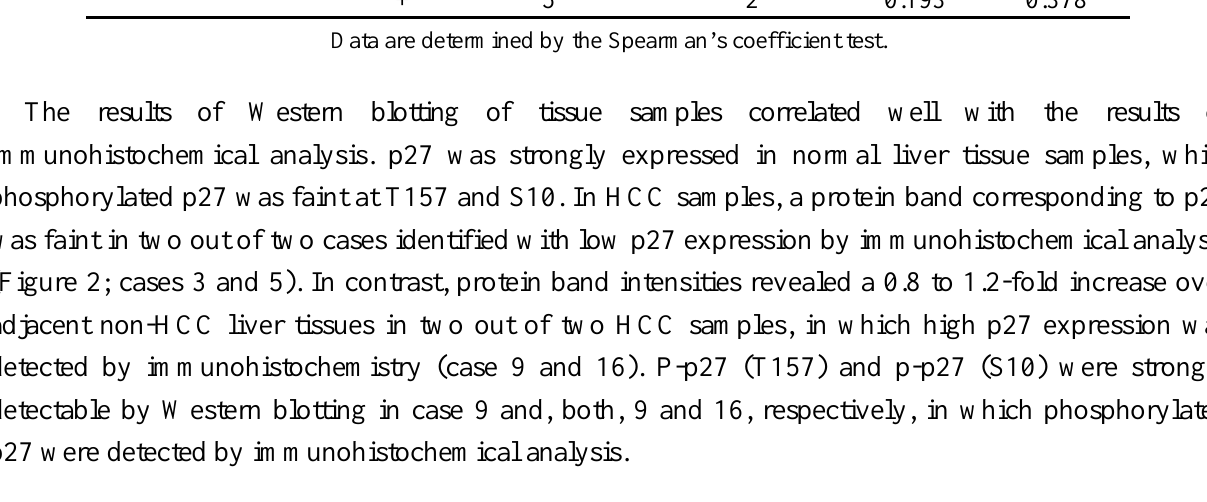
Figure 2. Analysis of p27 expression in HCC in representative tissue samples by western blotting. Numbers represent tissue samples obtained from NASH patients with HCC. The results of immunohistochemical staining (IHC scoring) in each sample are shown at the bottom of each lane. T, tumor tissues; N, adjacent non-tumorous tissue for each HCC sample; normal, normal liver (C1 and C2; normal cases 1 and